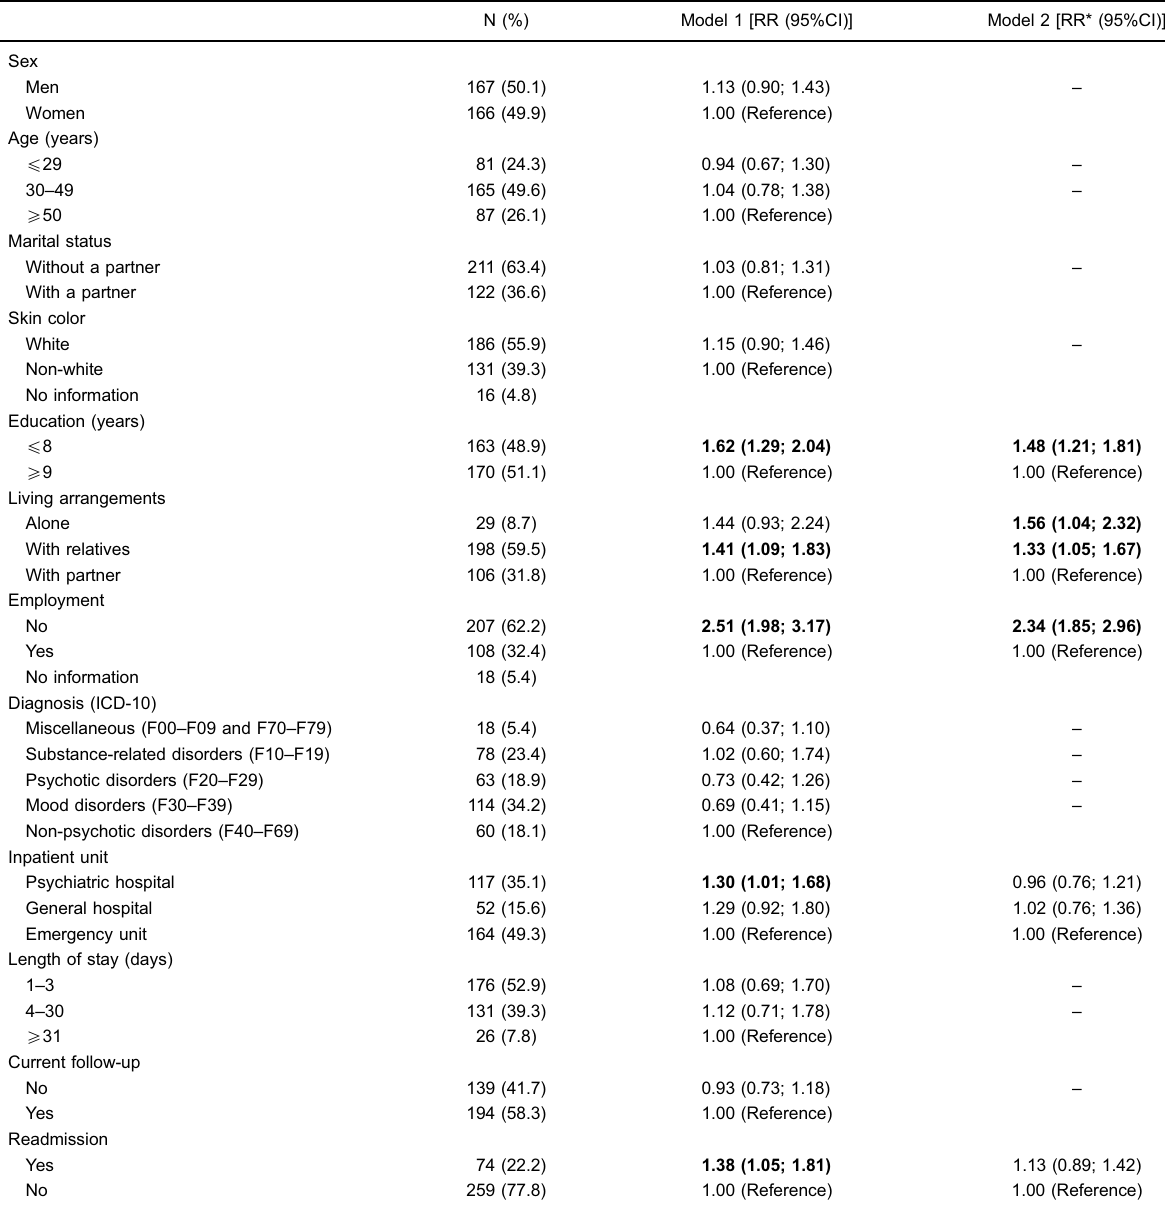
Table 2. Predictors of the needs (met + unmet) of patients at least four years after their fi rst psychiatric admission according to zero- in fl ated negative binomial (ZINB) regression